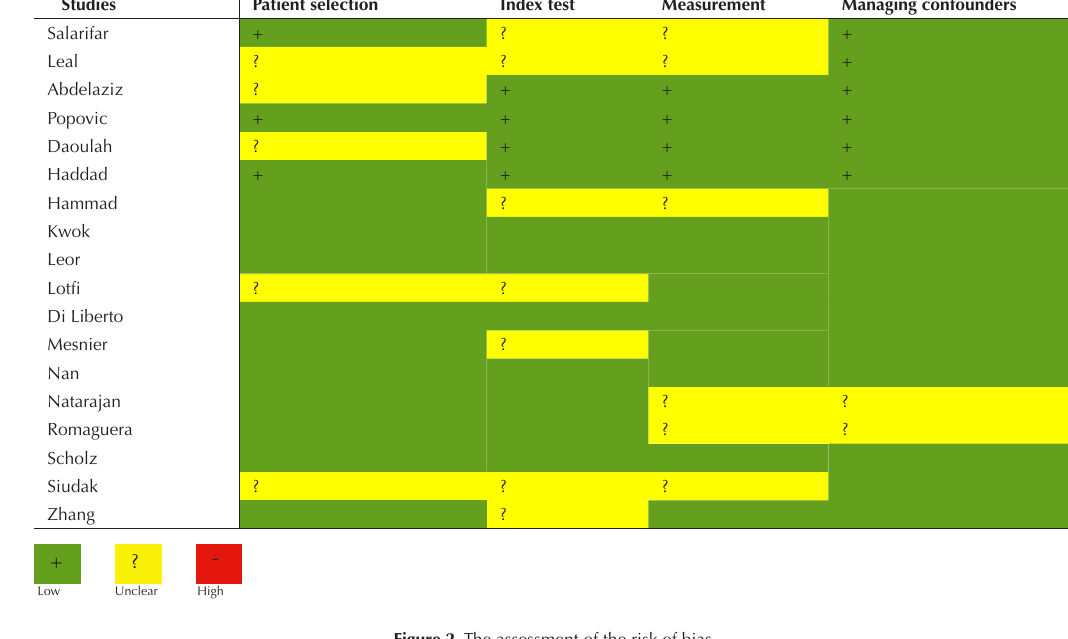
Figure 2. The assessment of the risk of